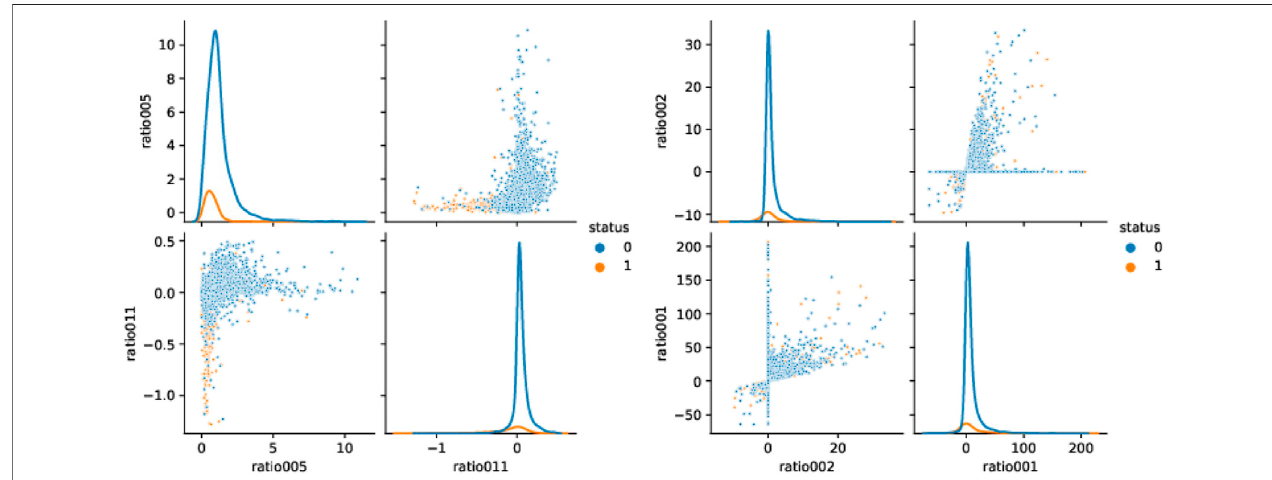
FIGURE 1 | Scatter plots and densities for the two ratios with the best p -values and for the two ratios with worst p -values, from left to right, respectively.